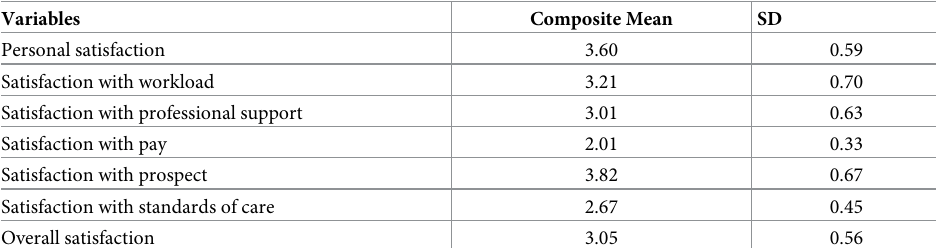
Table 2. Job satisfaction of midwives.